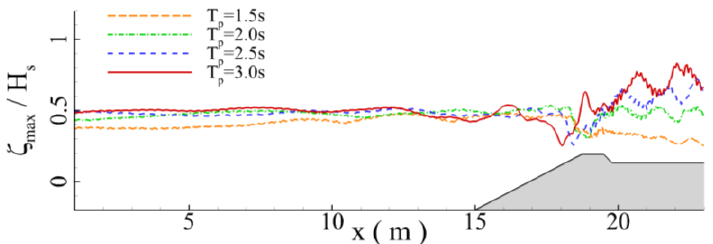
Figure 26. Space distributions of the local maximum water surface elevation.